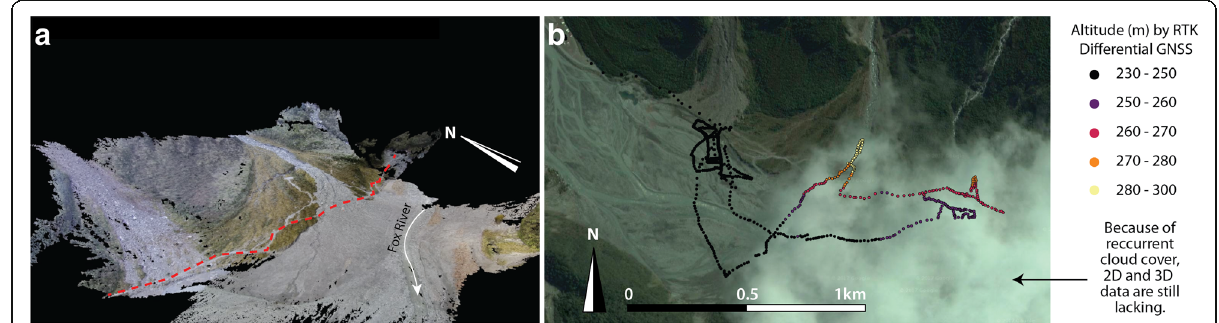
Fig. 4 Point cloud of the portion of the study area, where the simulation has been run, as generated by Structure from Motion Multiple View Stereophotogrammetry, as well as the position of the RTK-GNSS points and their altitude. The imagery also points out another issue in the valley: the lack of aerial and satellite imagery to monitor change and evolution in the valley because of the important cloud cover. a Perspective view of the point cloud with the tourist track indicated by the red dotted line, managed pathways on the valley talweg and on the fans, allowing a walk to a vantage point on the glacier. b Plan view of the area under cloud